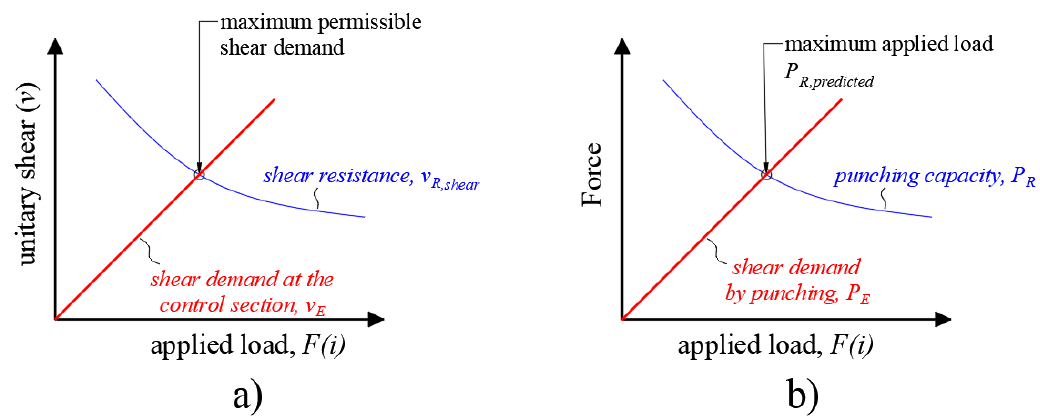
Figure 3. Determination of the ( a ) unitary shear resistance v R,shear and ( b ) punching capacity P R,predicted iteratively for the fib Model Code expressions.